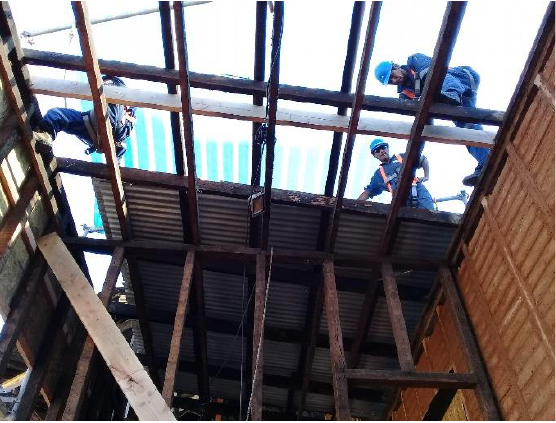
Figure 7. Structural consolidation of wooden